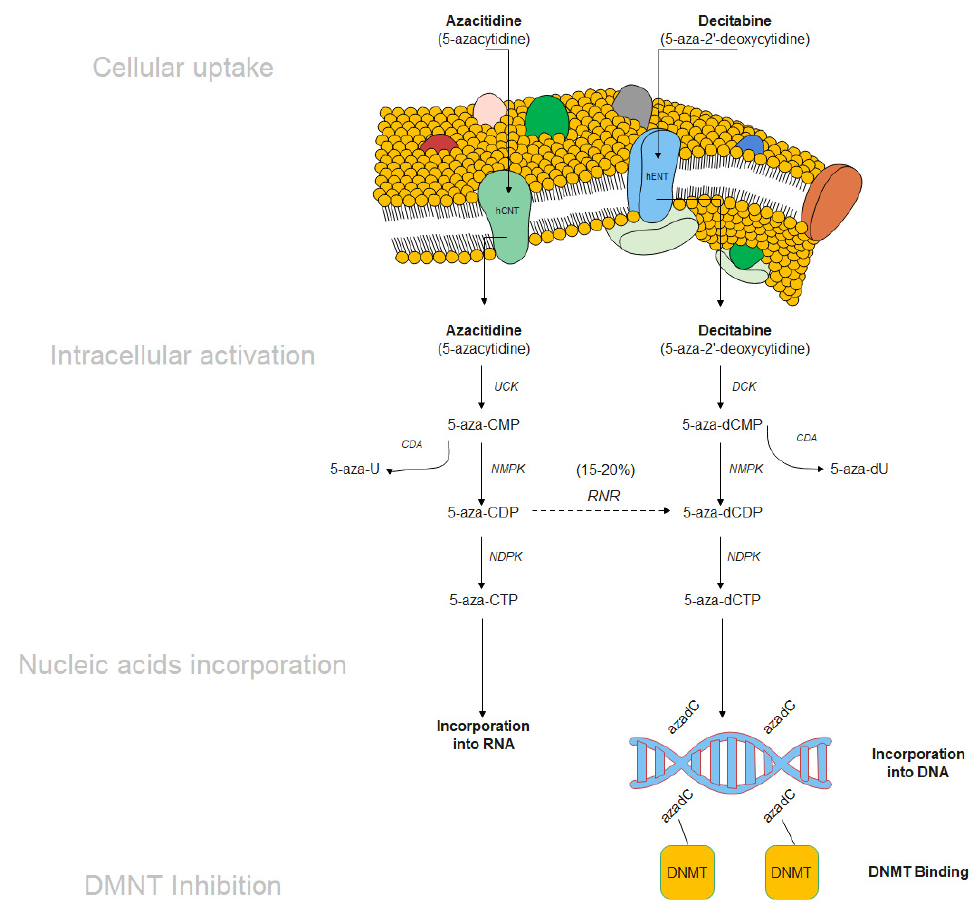
Figure 5. Schematic representation of AZA and DEC uptake and metabolism. UCK—uridine-cytidine kinase, DCK—deoxycytidine kinase, CDA—cytidine deaminase, NMPK—nucleoside monophosphate kinase, NDPK—nucleoside diphosphatase kinase, RNR—ribonucleotide reductase.